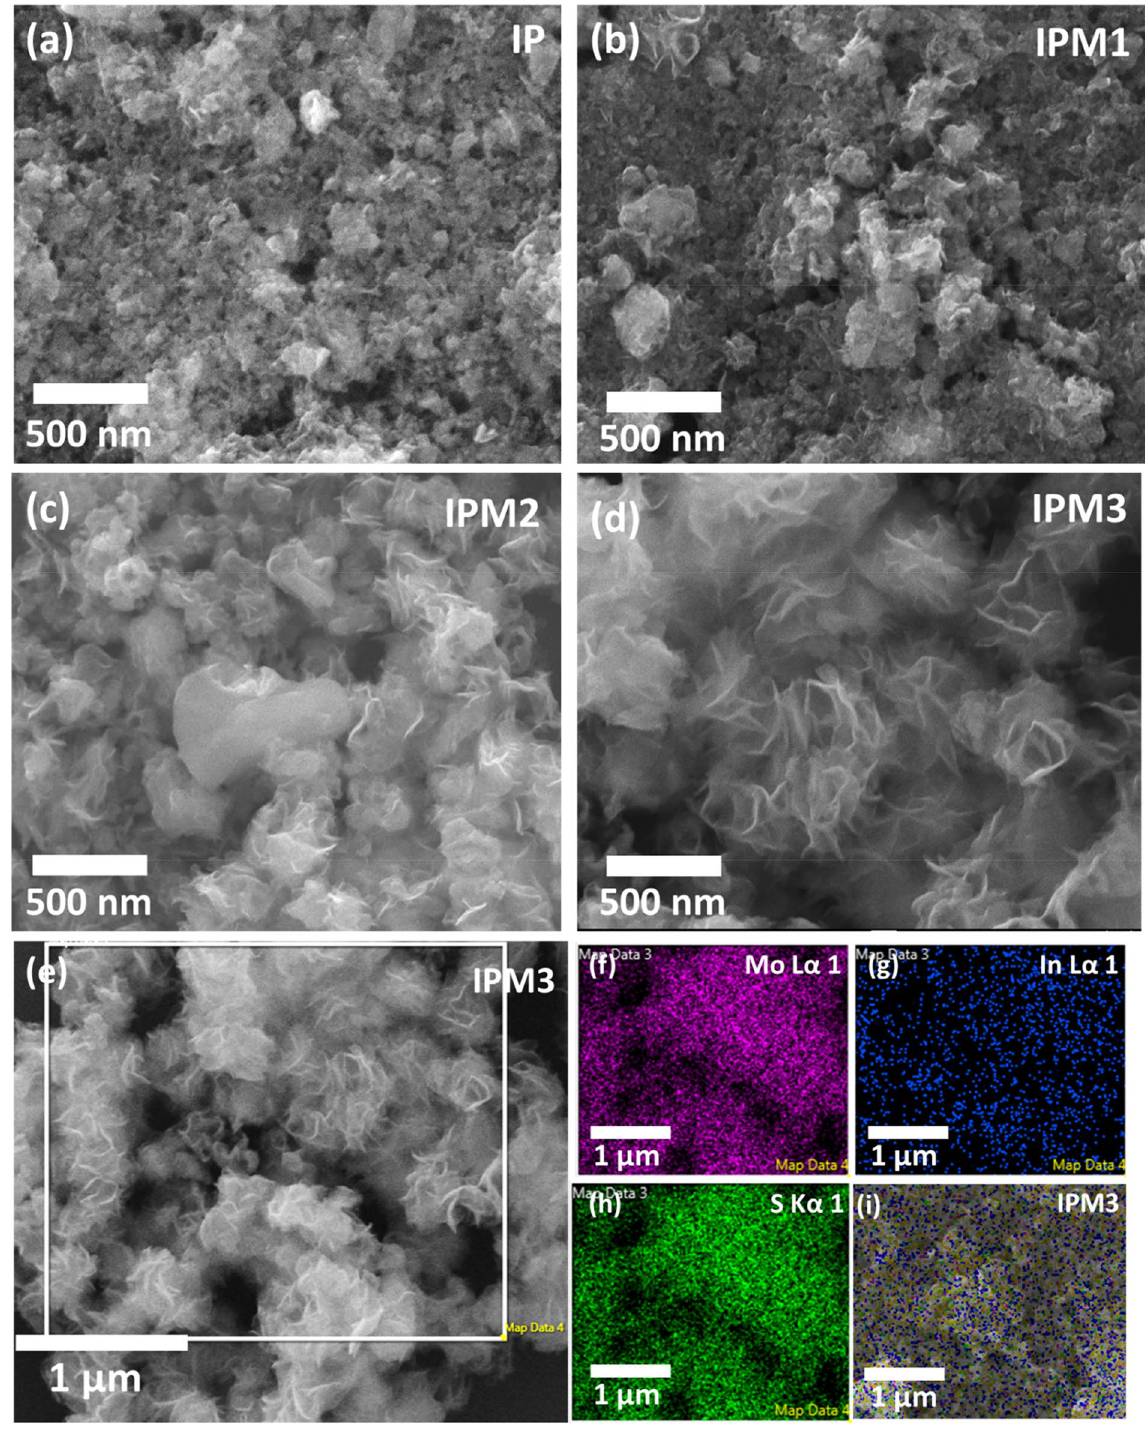
Figure 4. ( a – d ) FESEM images of sample IP, IPM1, IPM2, and IPM3 indicating the modulations in their morphology, ( e ) FESEM image of sample IPM3 revealing the formation of In 2 S 3 nanosheet decorated MoS 2 nanoflowers, ( f – h ) Chemical mapping of sample IPM3 assuring the independent existence of In, Mo, and S atoms in sample IPM3, ( i ) Mapped image of sample IPM3 assuring the formation of In 2 S 3 –MoS 2